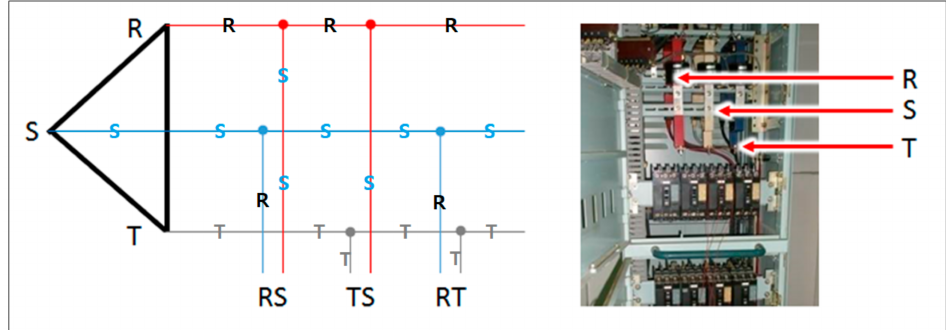
Figure 2. Three-phase three-wire delta connection (shipboard power line structure).